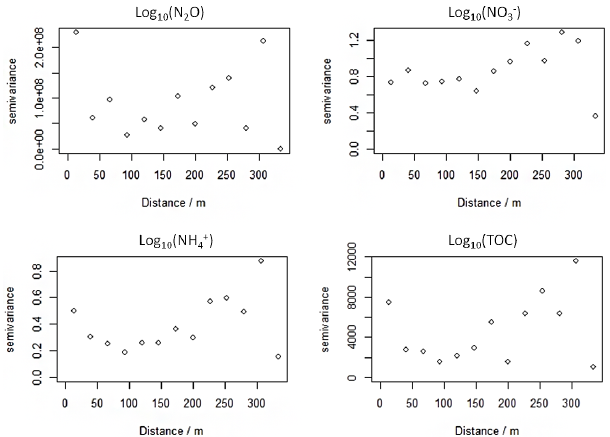
Figure 7. Variograms for N 2 O flux, NO − measured across the field scale. Log-normal distributions were used as in Fig. 6 and Table 2. The x axis is the distance between measure- ment locations in metres and the y axis is the semivariance in all of the respective measurements made for the entire